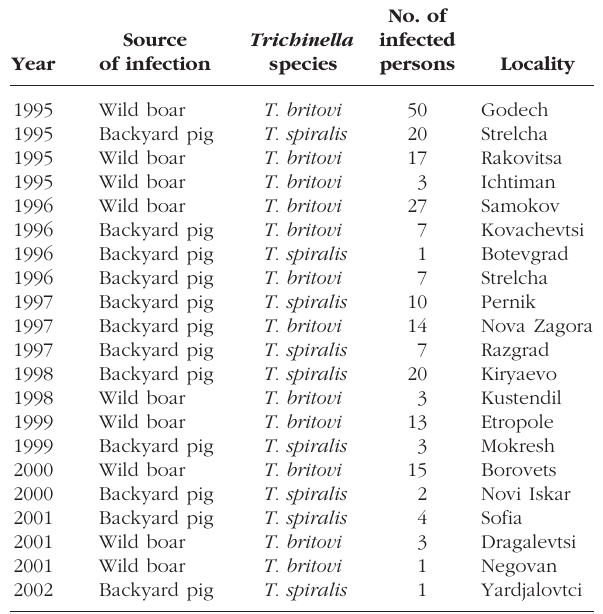
Table I. – Epidemiological data of 18 outbreaks and three single cases of trichinellosis detected in Bulgaria from 1995 to